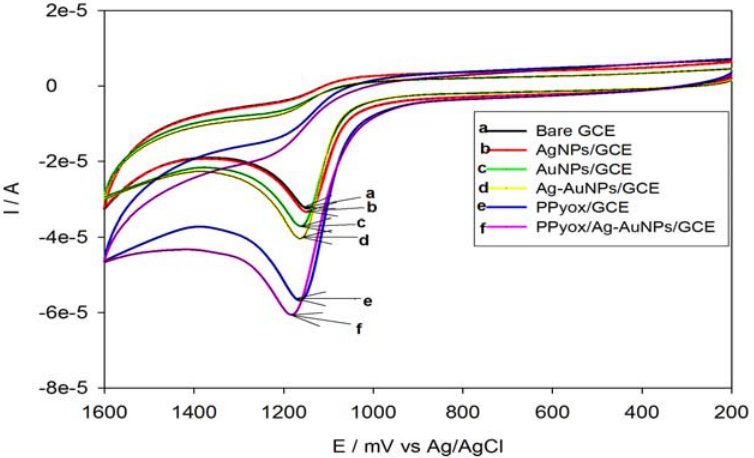
Figure 7. CV of 3.56 × 10 − 4 M anthracene at bare/GCE (curve a ), AgNPs/GCE (curve b ), AuNPs/GCE (curve c ), Ag-AuNPs/GCE (curve d ), PPyox/GCE (curve e ) and PPyox/Ag-AuNPs/GCE (curve f ) in acetonitrile and 0.1 M LiClO of 100 mV s − 1